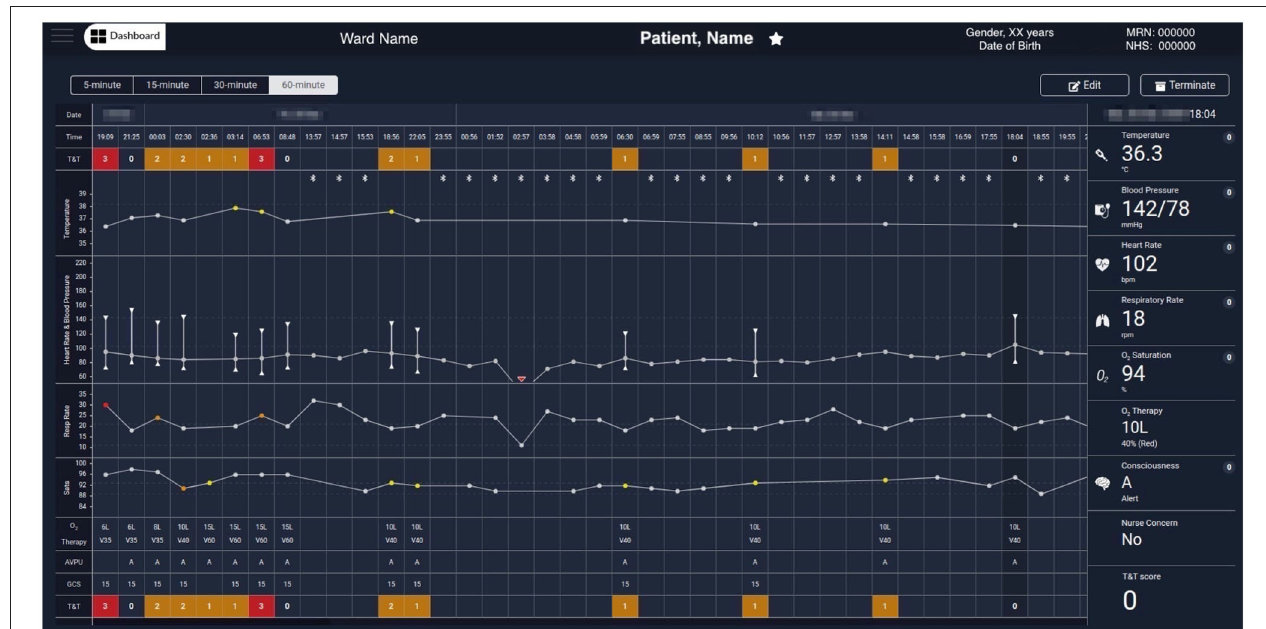
FIGURE 5 | Exemplar augmented e-obs chart from the Clinician Dashboard, showing wearable and e-obs vital-sign data from a COVID-19 patient in the isolation room. The header provides the patient’s demographics (from left to right): the ward, bay and bed location, the name, gender, age (with date of birth below), and the MRN and NHS codes. The clinicians have the option to “Edit” the patient information, or “Terminate” the patient’s session in the vHDU system (automatically unregistering them from the assigned tablet). The clinicians can review the periodic wearable data, i.e., the 5-min median estimates, using 15-, 30-, or 60-min windows (the most recent 5-min estimates in each window are shown), alongside the intermittent e-obs data (usually entered 4-hourly by the nurses), to facilitate tracking of the patient state. Wearable data is distinguished from the e-obs by using the Bluetooth sign at the top of the Temperature row. Only the e-obs data have scores associated with it, presented in the T&T row at the top and bottom of the chart. In this hospital setting, an Early Warning Score greater or equal to 3 was coloured red, denoting high risk. In this exemplar patient chart, only nurse observations (e-obs data) are present at the start, showing low SpO 2 (89% at 2:30 AM) and high RR, high Temp, and the use of oxygen therapy (26 rpm, 37.9 ◦ C and Venturi mask 60, V60, at 15 litres per minute, respectively, at 6:35 AM). The wearable data is summarised in hourly windows to allow the review of a longer monitoring period. It is possible to observe that during this period the VitalPatch ® and the Nonin devices were fitted to the patient from 13:00 and then temporarily removed between 16:00 and 23:00. Periodic VitalPatch ® data was then consistently available for remote monitoring of the patient status from the nurse bays; however, the Nonin was still removed often by the patient during that period (staff continued to try to use it to monitor the patient’s continuous oxygen therapy, which can be confirmed by the presence of the Venturi mask, V40, in the 4-hourly e-obs data present during this period). MRN, Medical Record Number; NHS, National Health Service; T&T, Track & Trigger; Sats, peripheral blood Oxygen Saturation; AVPU, Alert, Voice, Pain, Unresponsive scale; GCS, Glasgow Coma Scale; RA, Room Air; O 2 ,